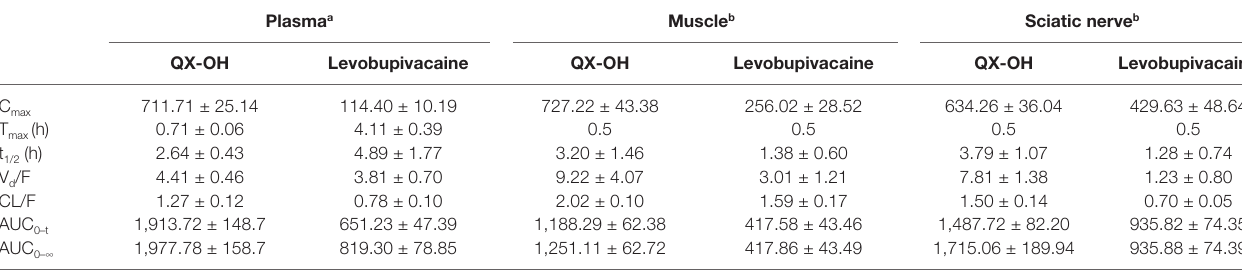
TABLE 1 | Tissue and systemic pharmacokinetic parameters of LL-1 after sciatic nerve block in rats (Mean ± SEM). Plasma a Muscle